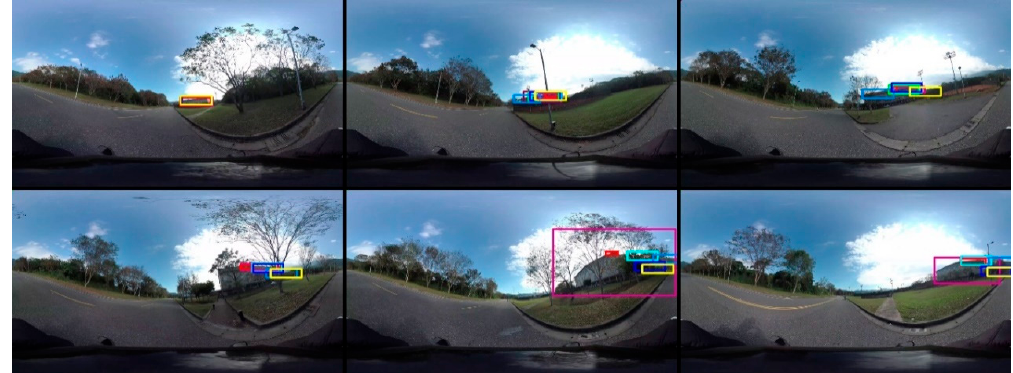
Figure 5. Tracking results on 360-degree video sequence 2 (tracking windows with different colors: MOSSE MIL MedianFlow BOOST TLD KCF GOTURN CSRT).